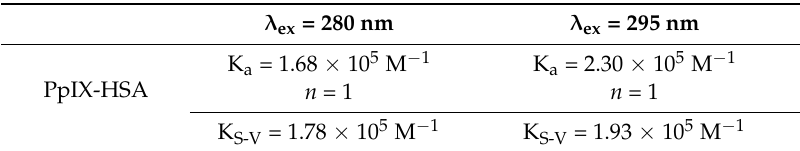
Table 1. Association constants (K a ), number of binding sites (n) and Stern–Volmer constants (K S-V ) for the PpIX-HSA complex.